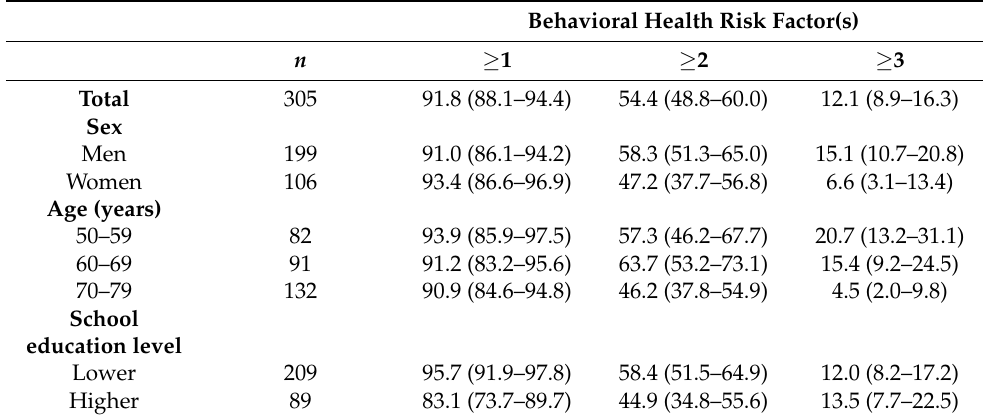
Table 4. Number of behavioral health risk factors in the total sample and stratified by sociodemo- graphic characteristics (percent, 95% confidence